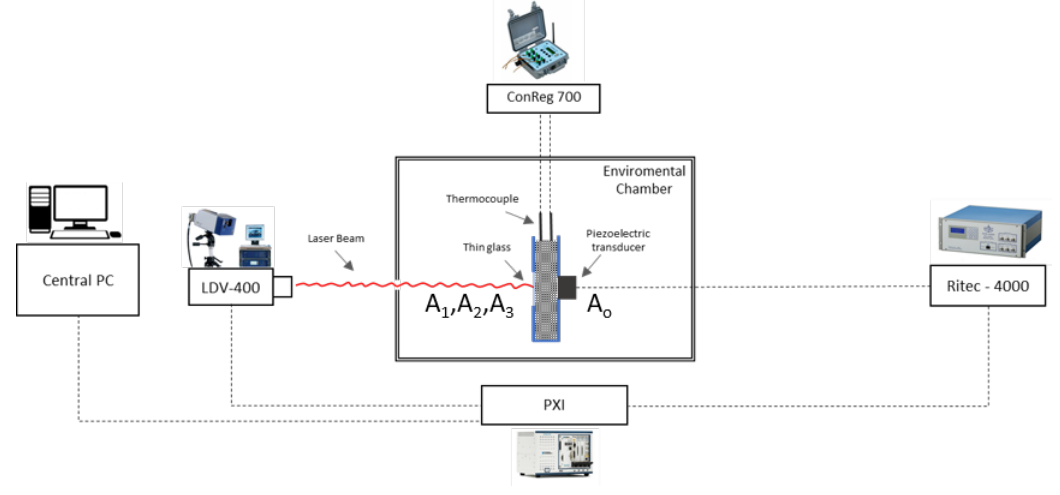
Figure 1. Experimental setup.